Question: Express in one sentence what the figure is showing.
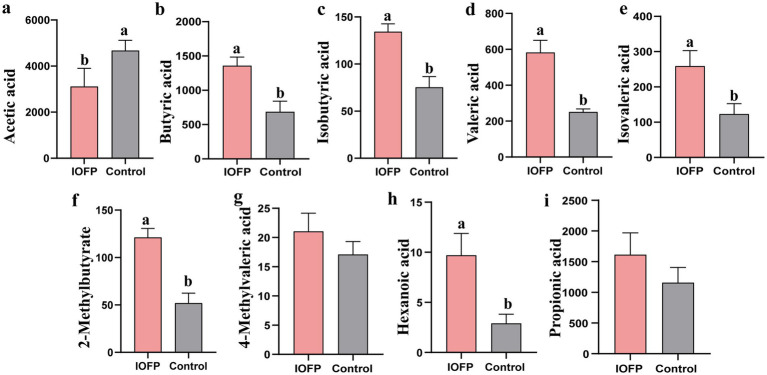
Answer: Effect of Inonotus obliquus fermentation product (IOFP) on intestinal short-chain fatty acids (SCFAs) of cats. (a) Contents of acetic acid in the IOFP and control groups. (b) Contents of butyric acid in the IOFP and control groups. (c) Contents of isobutyric acid in the IOFP and control groups. (d) Contents of valeric acid in the IOFP and control groups. (e) Contents of isovaleric acid in the IOFP and control groups. (f) Contents of 2-methylbutyrate in the IOFP and control groups. (g) Contents of 4-methylvaleric acid in the IOFP and control groups. (h) Contents of hexanoic acid in the IOFP and control groups. (i) Contents of propionic acid in the IOFP and control groups. Different lowercase letters indicate a significant difference ( p < 0.05) between the IOFP and control groups. The error bars are based on the standard error of means.